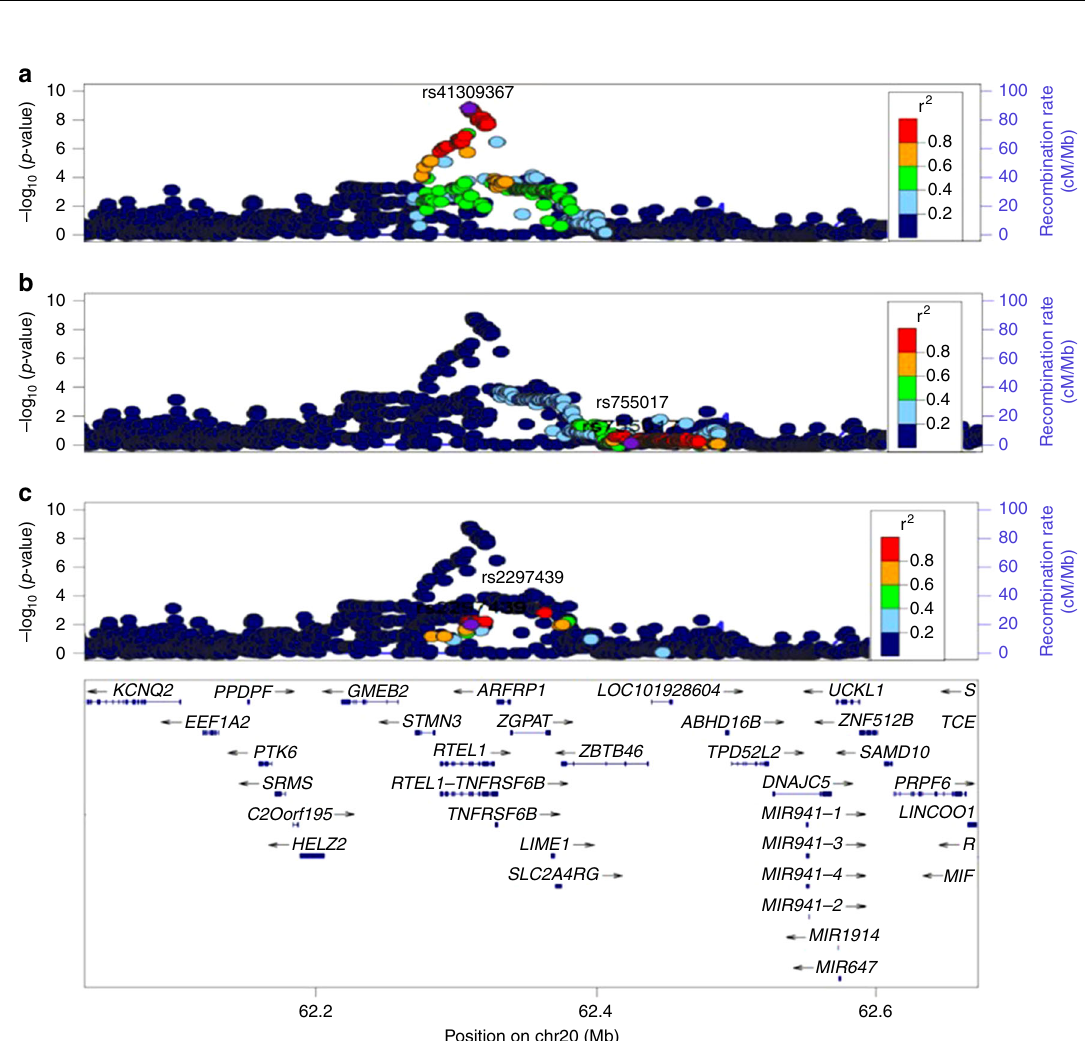
Fig. 3 Regional SNP associations at the RTEL1 gene locus in the SCHS discovery GWAS. a Association of lead SNP identi fi ed in the SCHS (rs41309367). b Association of previously identi fi ed index SNP from European GWAS studies (rs755017). c Association of previously identi fi ed index SNP from South Asian GWAS studies (rs2297439). Lead SNP indicated as purple diamonds. LD ( r 2 ) data of SNPs based on ASN panels of 1000Genome database. Plots plotted using LocusZoom